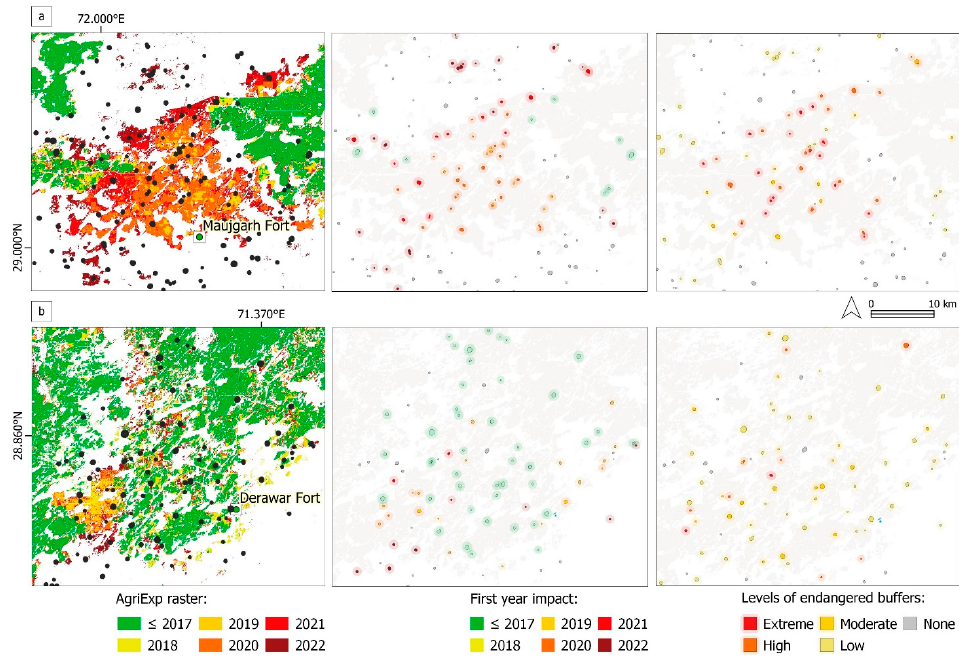
Figure 6. Critically endangered regions since 2018 onwards: ( a ) the lands west of Derawar Fort, and ( b ) the rangelands near Maujgarh Fort. The image shows three distinct AgriExp-classified outputs exported to common GIS platforms: (1) AgriExp raster with the first year of agricultural impact; (2) the classified table showing the first year of impact; and (3) categorical levels of endangered mound surfaces.